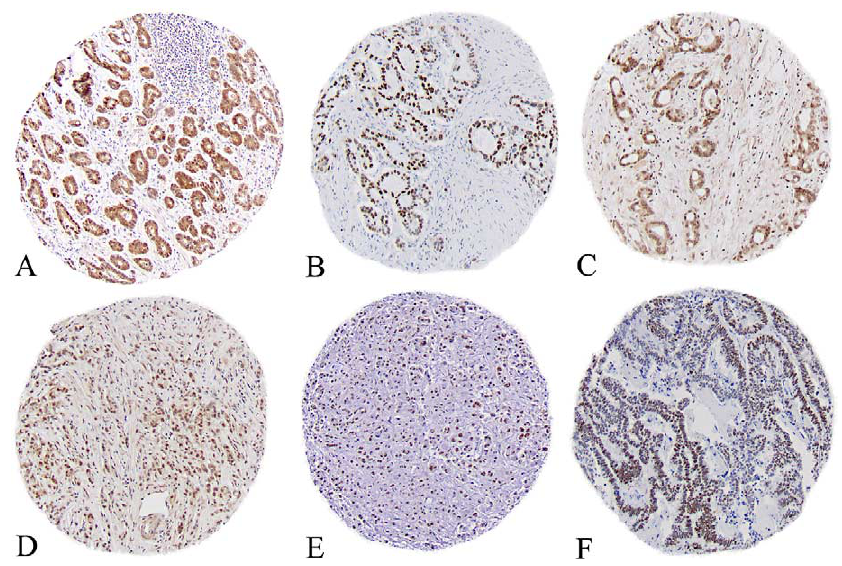
Fig. 2. Immunohistochemistry for cdc4 (A), cyclin E (B), c-myc (C), c-jun (D), Notch (E) and p53 (F) ( × 100) on tissue microarray cores.